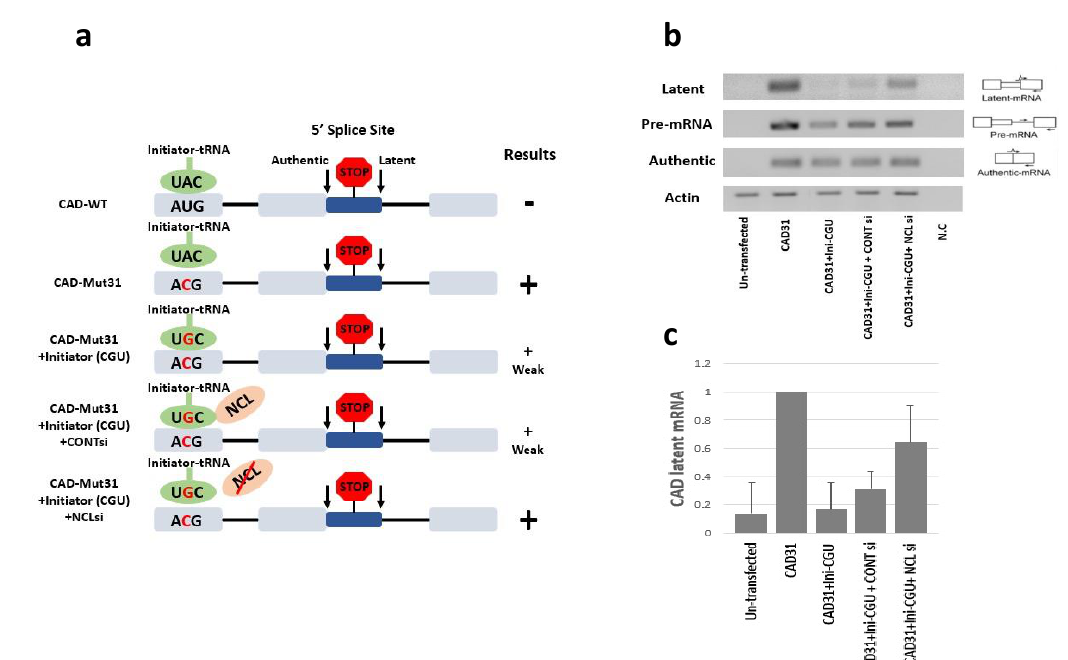
Figure 2. A potential role for NCL in SOS. The recovery of SOS by ini-tRNA complementation is NCL dependent. ( a ) Hypothesis and experimental design. Assuming that ini-tRNA is essential in establishing a reading frame required for the SOS mechanism, latent splicing is suppressed when CAD-WT is complemented by ini-tRNA with a complementary anticodon (CAU). It is expected that abrogating SOS in an AUG to ACG mutant (CAD-Mut31), elicits latent splicing, which is rescued by a mutant in-tRNA, which carries a complementary anticodon (CGU) mutation, resulting in a reduced level of latent splicing (CAD-Mut31). These assumptions were verified [40]. Notably, recovery of SOS by ini-tRNA complementation is disrupted by NCL knockdown using siRNA. Scheme: gray box, exon; line, intron; blue box, latent exon; +(w) indicates weak latent splicing. ( b , c ) Experimental verification using the CAD minigene. HEK 293 cells were co-transfected with CAD-Mut31 (CAD31), which carries the mutated ACG start-codon; with CAD31 together with mutant ini-tRNA, in which the antisense codon was mutated to CGU (ini-CGU), as indicated. Co-transfection of CAD-Mut31 with mutant ini-tRNA and with si-RNA directed against NCL (NCLsi), disrupt the complementation. ( c ) Graphs represent an average of three independent experiments. The densitometric ratio of CAD31 was normalized to 100%. Adapted from ref. [46].